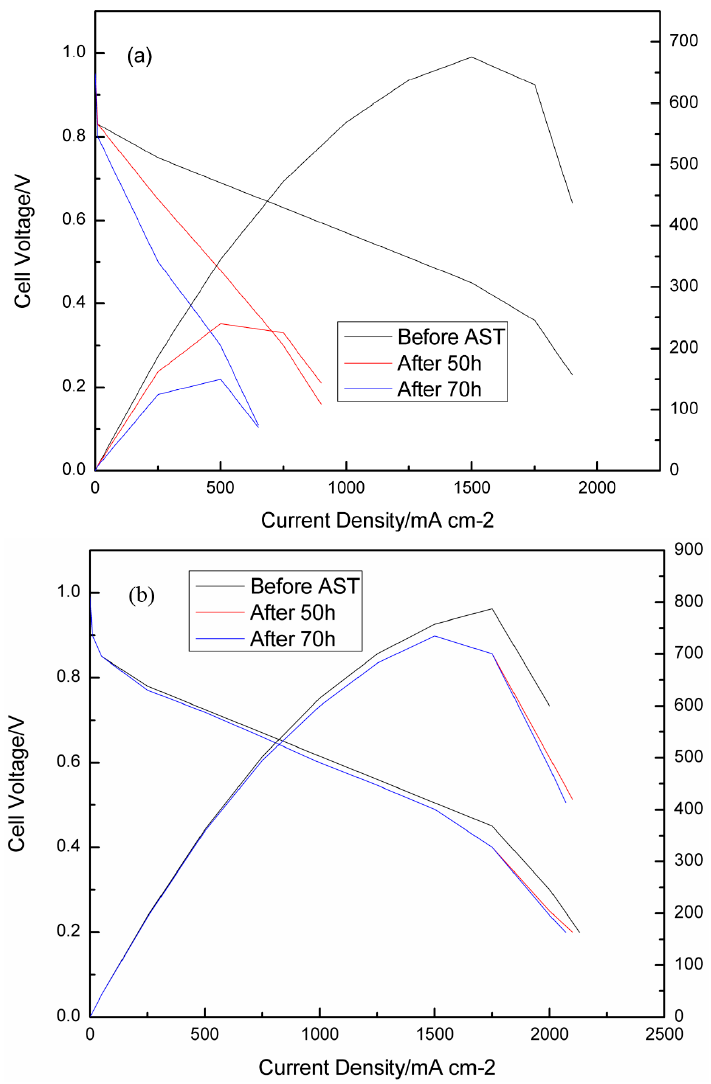
Figure 6. Steady-state performance curves for PEFCs with ( a ) Pt/Non-GrC and ( b ) Pt/GrC cathodes Figure 6. Steady ‐ state performance curves for PEFCs with ( a ) Pt/Non ‐ GrC and ( b ) Pt/GrC cathodes